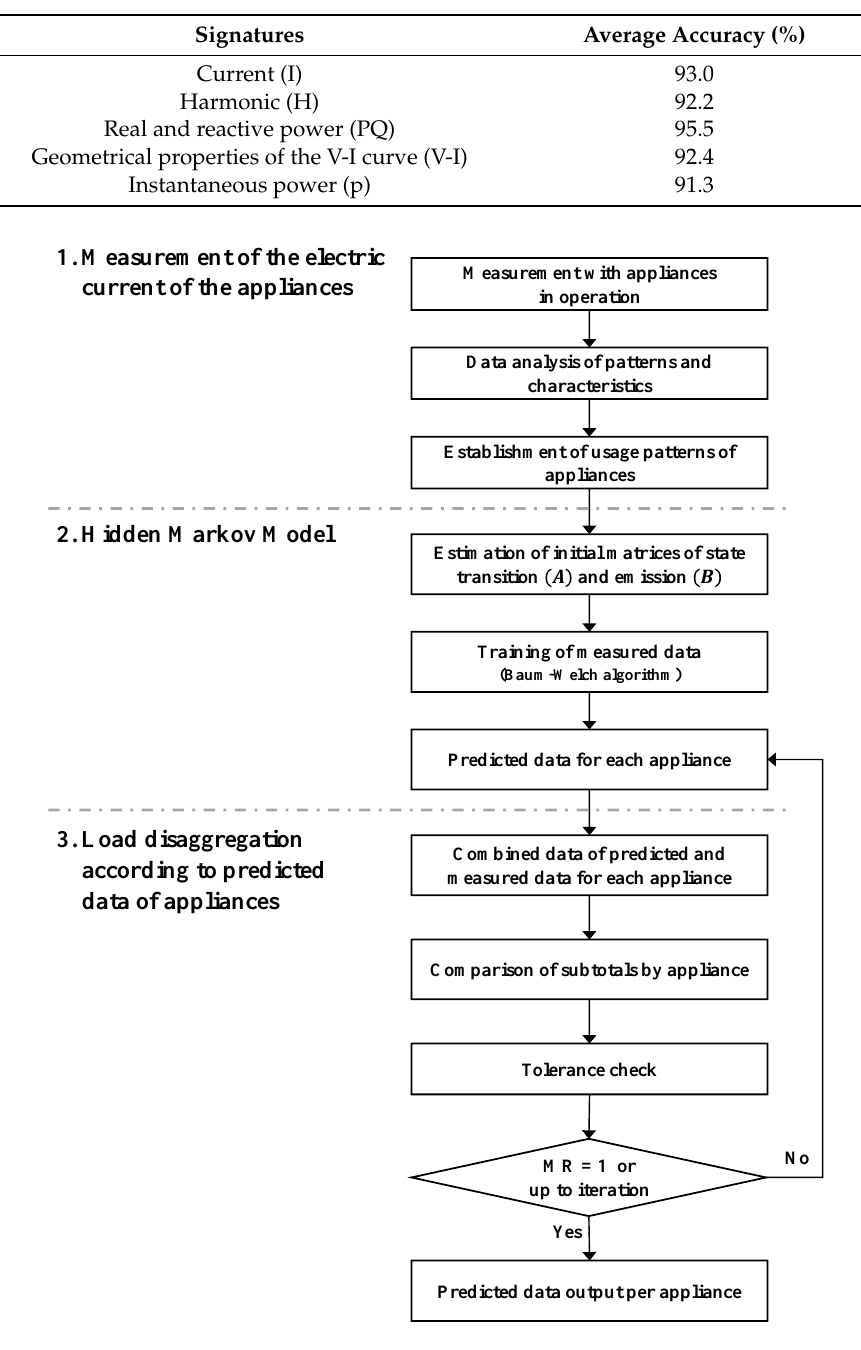
Table 2. Comparison of average identification accuracy according to signatures [6].